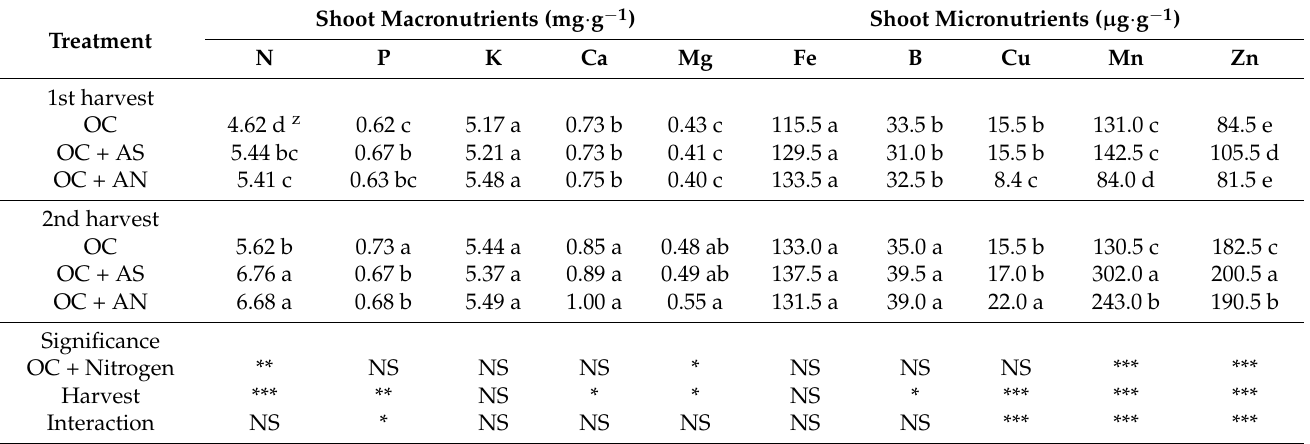
Table 2. Effect of organic compost combined with inorganic nitrogen fertigation on shoot nutri- ents’